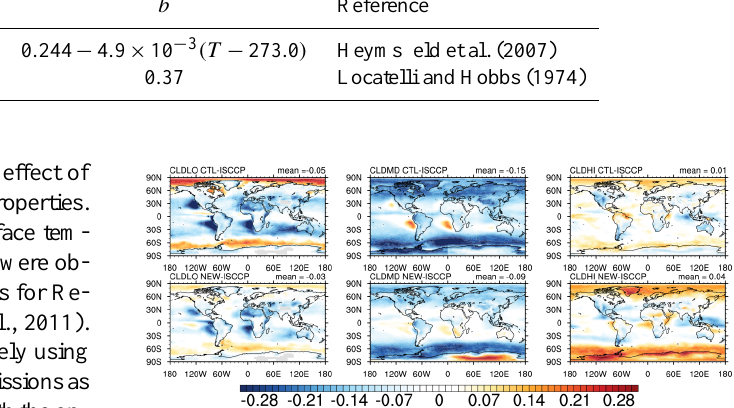
Figure 1. Annual mean differences in low- (CLDLO), middle- (CLDMD) and high- (CLDHI) level cloud fraction between GEOS- 5 and ISCCP (Rossow and Schiffer, 1999) for the CTL and NEW runs using the COSP